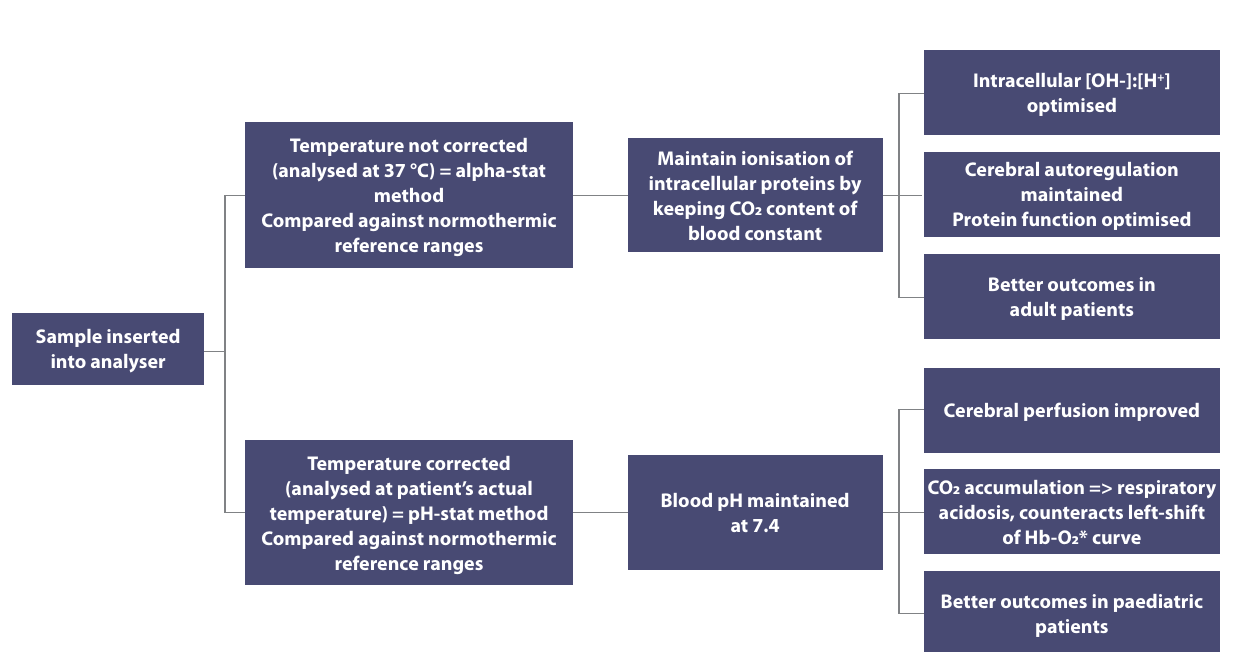
Figure 2: A summary of the alpha-stat versus pH-stat methods of blood gas analysis *Hb-O2 – Haemoglobin oxygen dissociation